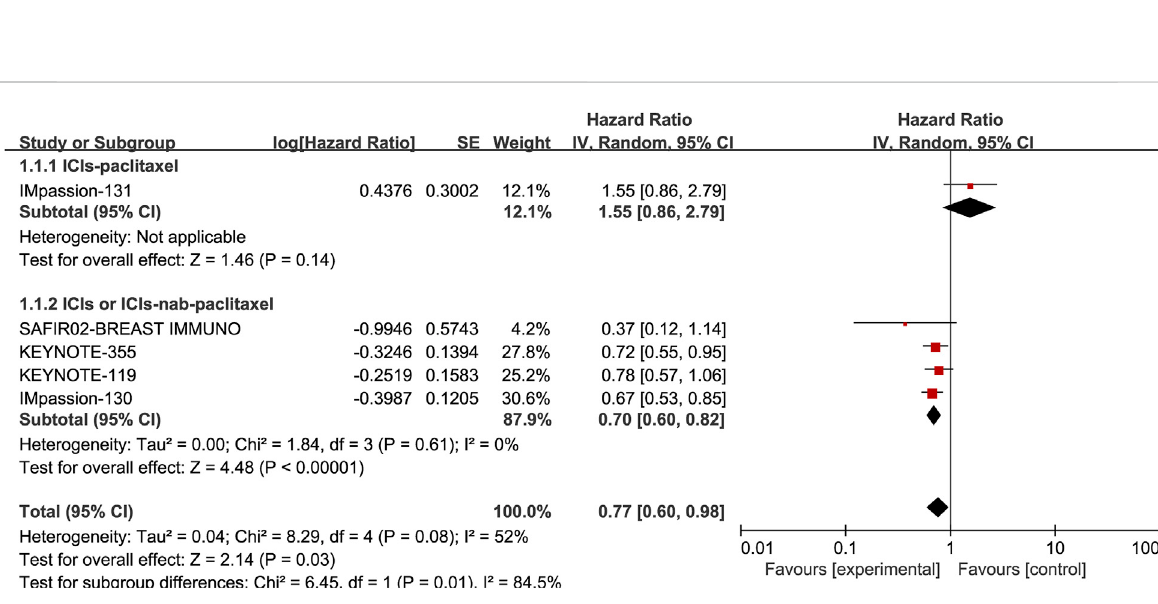
FIGURE 6 Subgroup analysis of the effect of ICIs combined with paclitaxel or not on OS in PD-L1 positive TNBC patients.